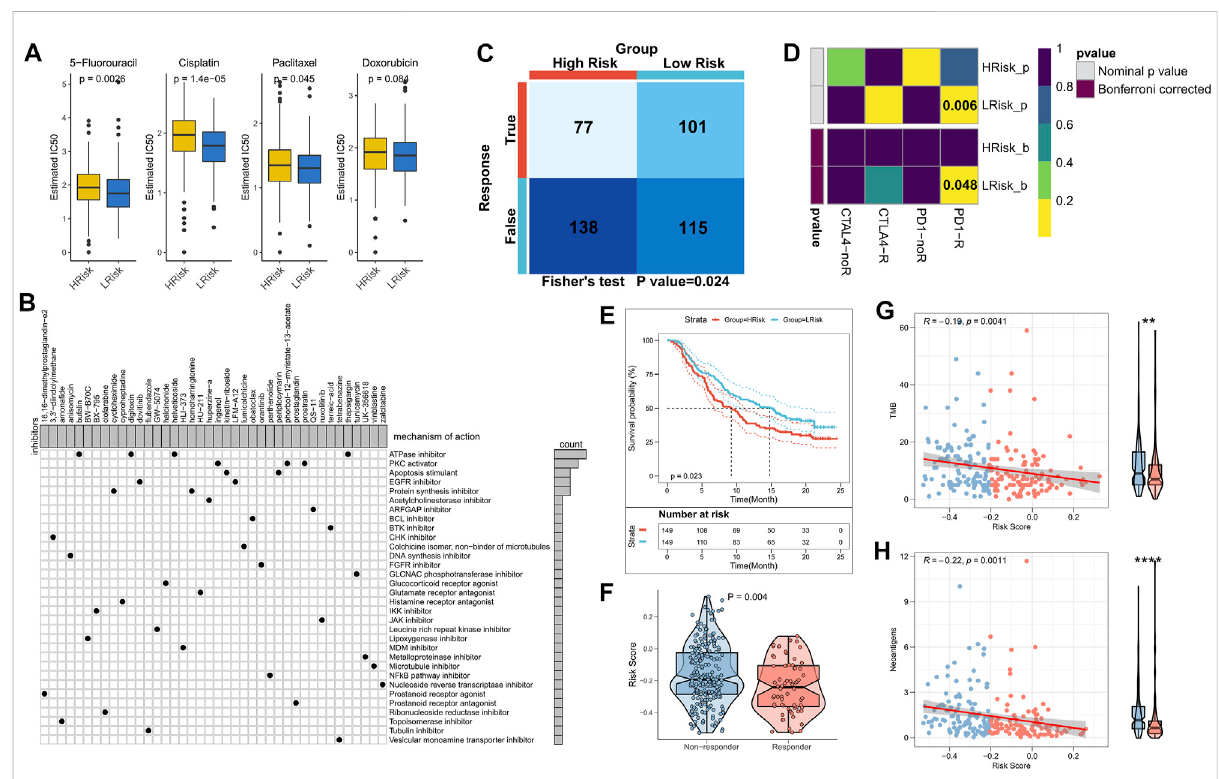
FIGURE 7 Role of the NRG-related risk model in guiding clinical treatment and decision-making. (A) . Box plot showing predicted IC50 values for four commonly used drugs in the high-risk and low-risk groups; (B) . Oncoplot showing the small molecule compounds, wherein the horizontal axis represents the name of the small molecule inhibitor and the vertical axis represents the biological pathway targeted by the corresponding small molecule inhibitor; (C) . TIDE algorithm for predicting responses to immunotherapy between the high-risk and low-risk groups; (D) . Subclass mapping for predicting sensitivity to PD1 and CTLA4 treatment in patients belonging to the high-risk and low-risk groups; (E) . KM survival curves for the high-risk and low-risk groups in the IMvigor 210 cohort; (F) . Box plot showing the differences in RiskScore between patients in the treatment- responsive and non-responsive groups of the IMvigor 210 cohort; (G) . Correlation between RiskScore and TMB in the IMvigor210 cohort; (H) . Correlation between RiskScore and neoantigens in the IMvigor 210